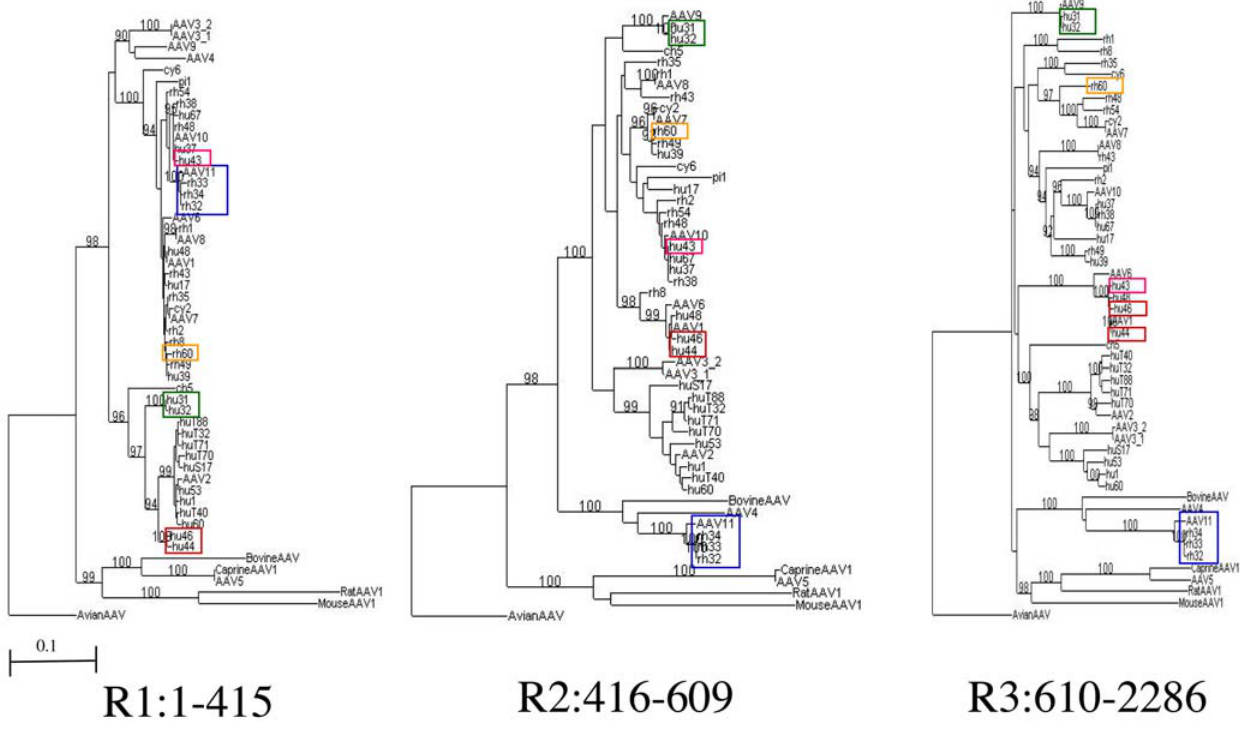
Figure 2. Local phylogenetic trees between 53 AAV cap sequences. Neighbour-joining trees were produced based on the nucleotide alignment for 3 regions: R1, VP1 unique; R2, between VP2 and VP3 N-termini; R3, VP3 coding region shared by all VP 1-3 (see Fig 1). Phylogenetic discordance between the three regions was observed for recombinant sequences. Tree structure difference between regions, particularly R1 versus R3, demonstrates the mosaic nature of the cap gene. Fifty-three sequences were selected by excluding sequences of non-mammalian origin (except an avian AAV used as the root), sequences derived from Tulane/F953 monkey and a number of ‘redundant’ sequences as indicated in Table S1. Bootstrap scores greater than 90 % are shown. Recombinant sequences depicted in Fig 1B–F are colour-boxed. A branch length scale common for all three trees is shown.